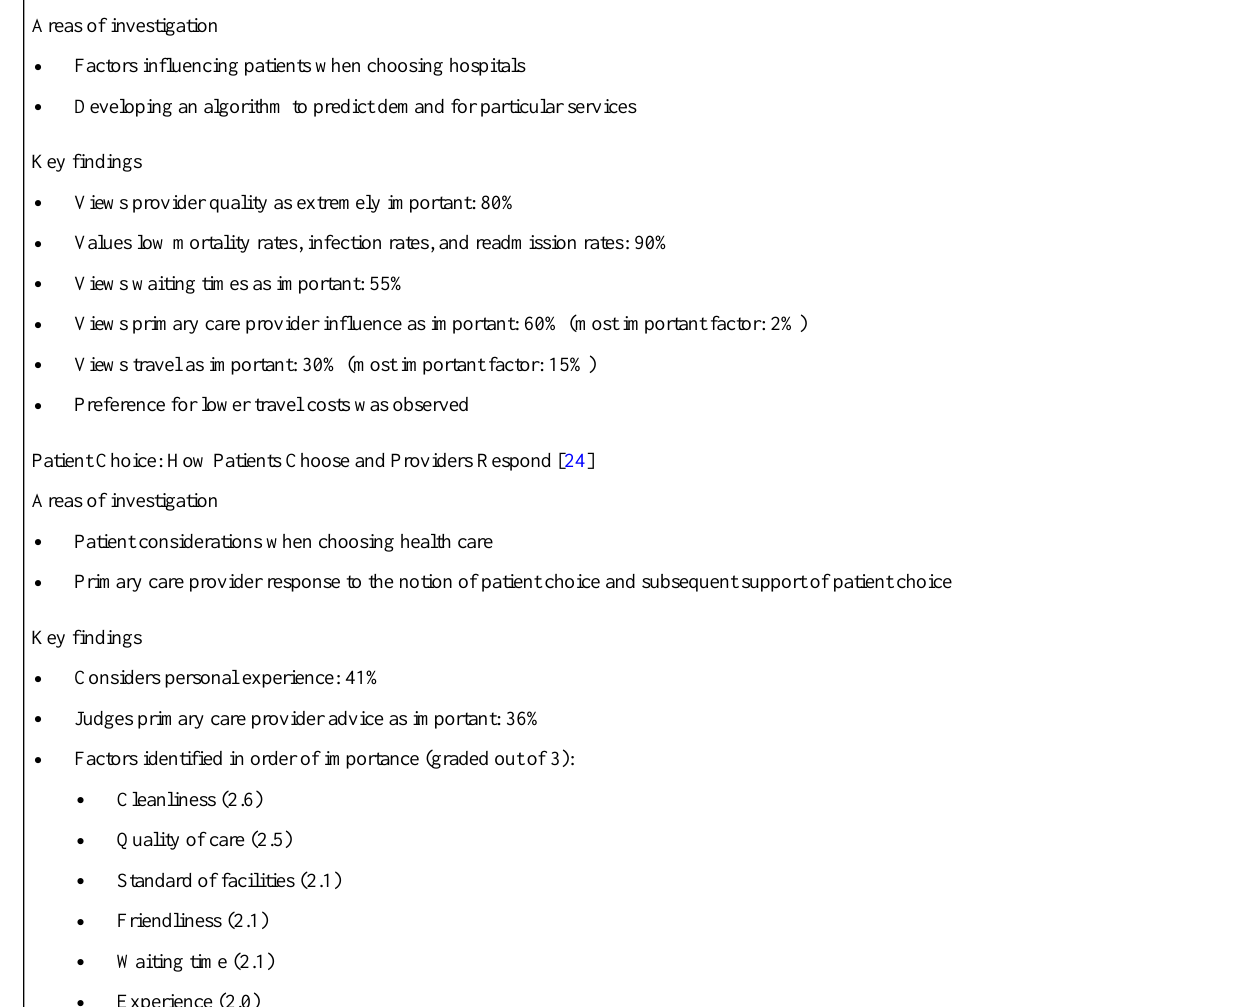
Textbox 1. Summary of the literature review: key factors guiding patient choice. Understanding Patients’Choices at the Point of Referral [28] Areas of